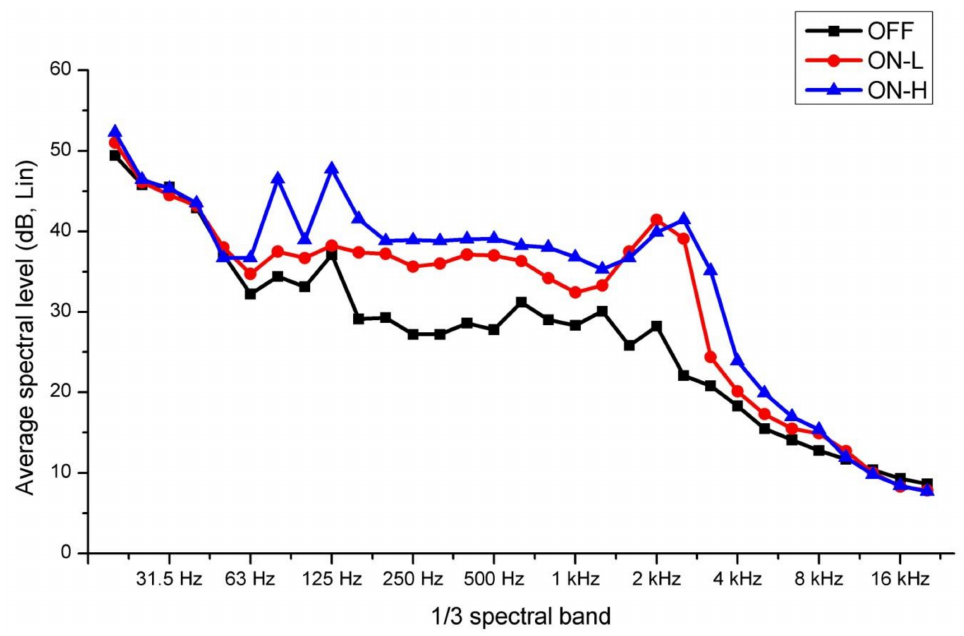
Figure 4. Average spectral levels in the 1/3 octave band, between 20 Hz and 20 kHz, for each of the three observation periods